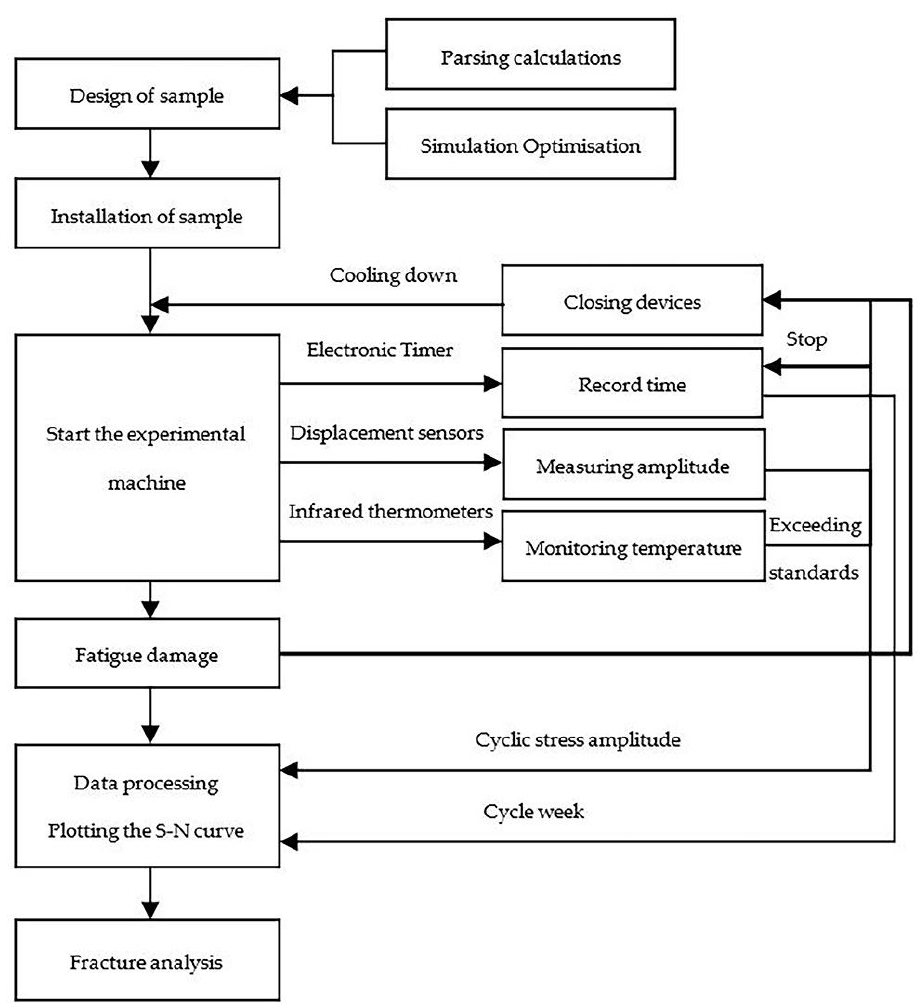
Figure 12. Flow chart for ultrasonic fatigue testing.